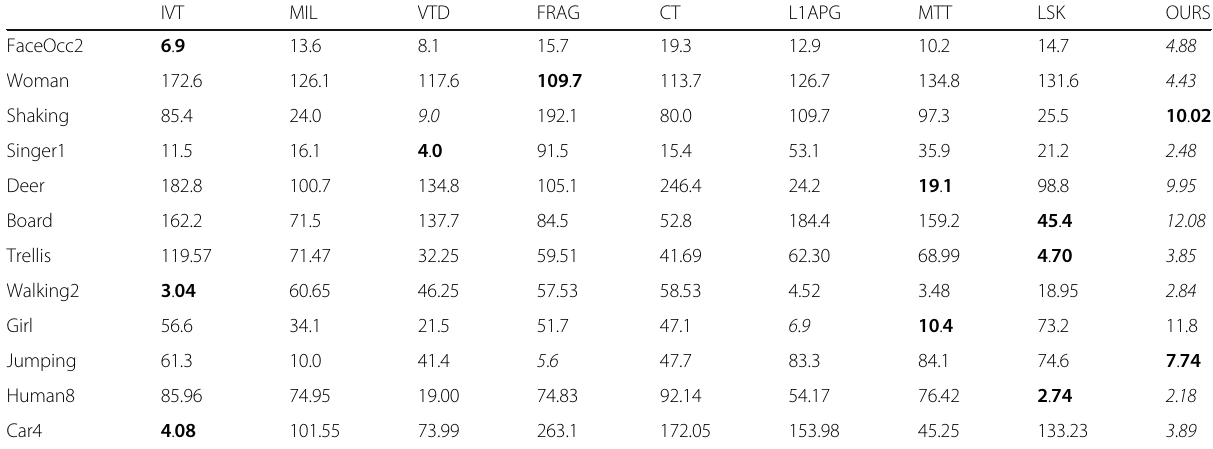
Table 2 Average center location error (in pixel). The best and second best results are shown in italic and bold